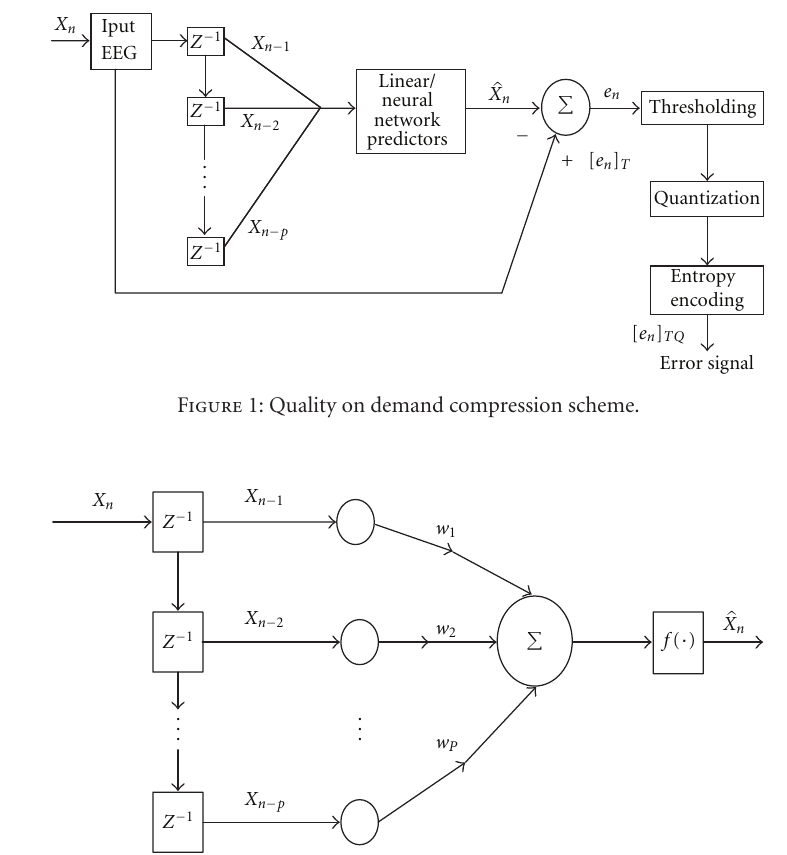
Figure 2: A P -th order single-layer perceptron